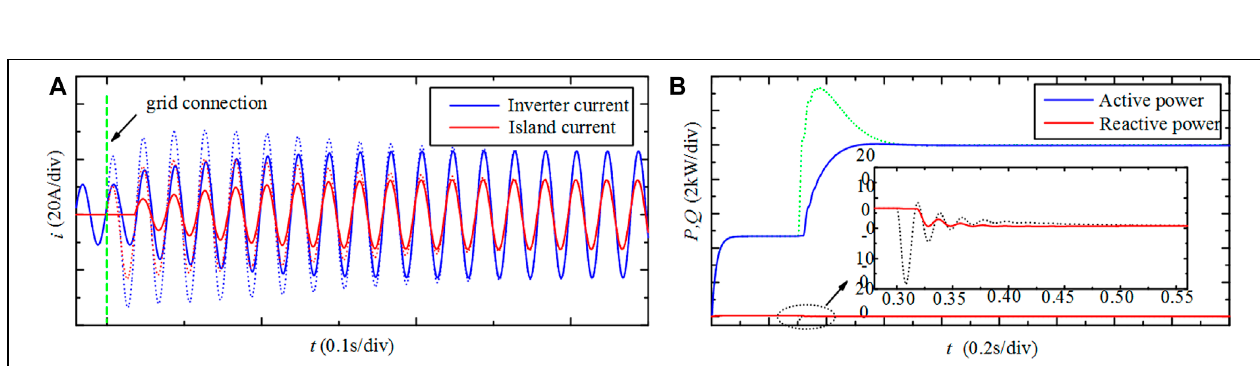
FIGURE 8 | Grid connection effect under the novel pre-synchronization method: (A) the current changed; (B) the power